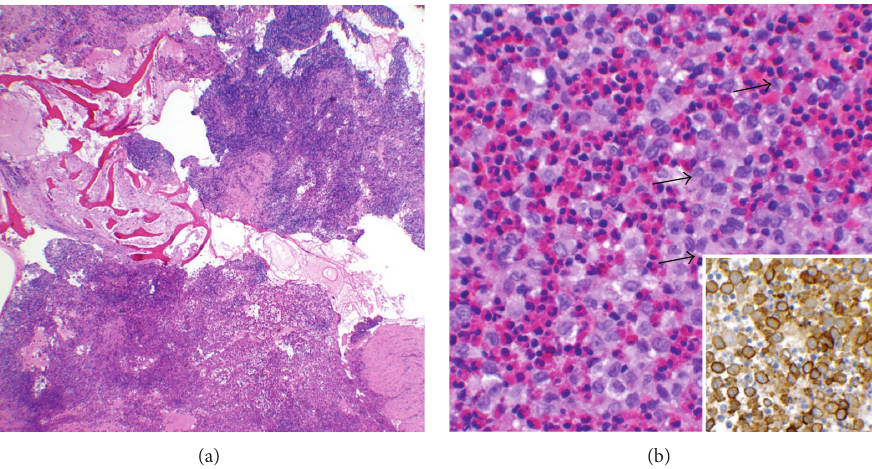
Figure 5: (a) Low magnification shows tumor cells expanding and destroying bony trabeculae (hematoxylin-eosin stain, original magnification × 40). (b) High magnification demonstrates tumor cells characterized by coffee bean-shaped grooved nuclei indicated by the arrow, admixed with eosinophils consistent with Langerhans cells (hematoxylin-eosin, original magnification × 400). Insert: CD1a immunostain is a transmembrane antigen normally found on Langerhasn cells (CD1a immunostain, original magnification ×